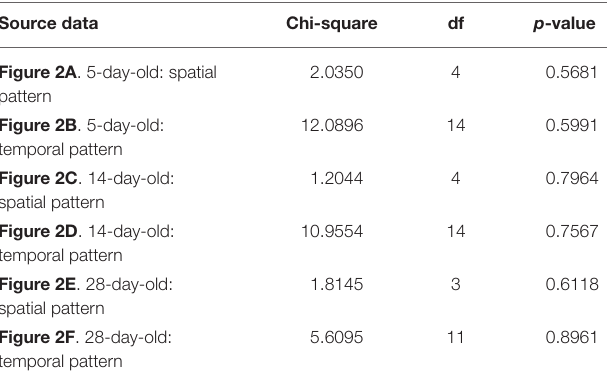
TABLE 3 | Comparison between re-capture patterns: experimental vs. model-generated. Source data Figure 2A . 5-day-old: spatial pattern Figure 2B . 5-day-old: temporal pattern Figure 2C . 14-day-old: spatial pattern Figure 2D . 14-day-old: temporal pattern Figure 2E . 28-day-old: spatial pattern Figure 2F . 28-day-old: temporal